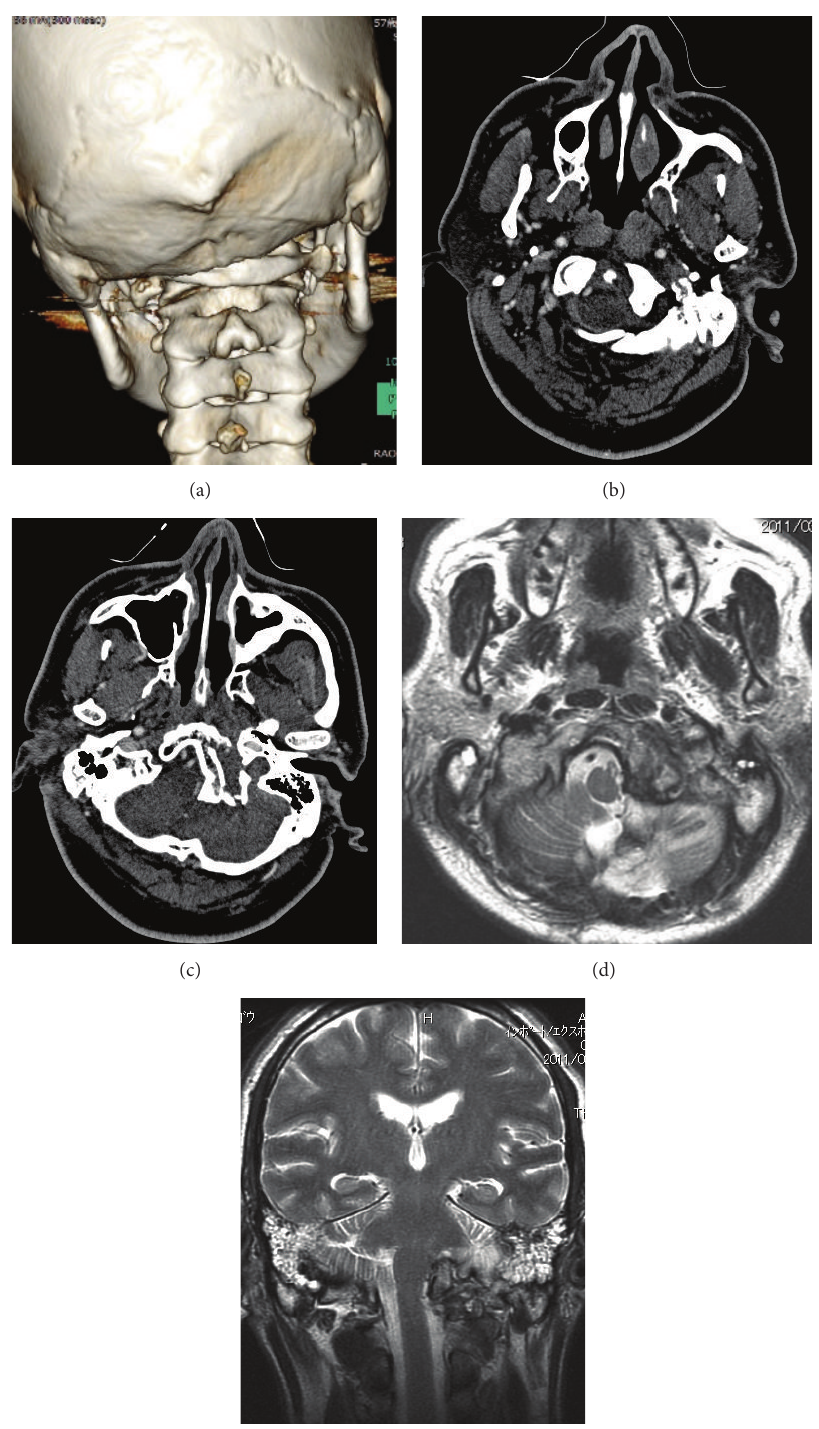
Figure 1: Images from a three-dimensional computed tomography (a), enhanced computed tomography (b and c), and magnetic resonance imaging (d and e) when the patient was first examined. The dislocated C1 that accompanied the occipital condyle fractures was intracranially impacted (a, b, and c). The left vertebral artery was not revealed by CT angiography (b and c). Cerebellar edema occurred due to traumatic hemorrhagic cerebellar contusions, which compresses the brainstem (d and